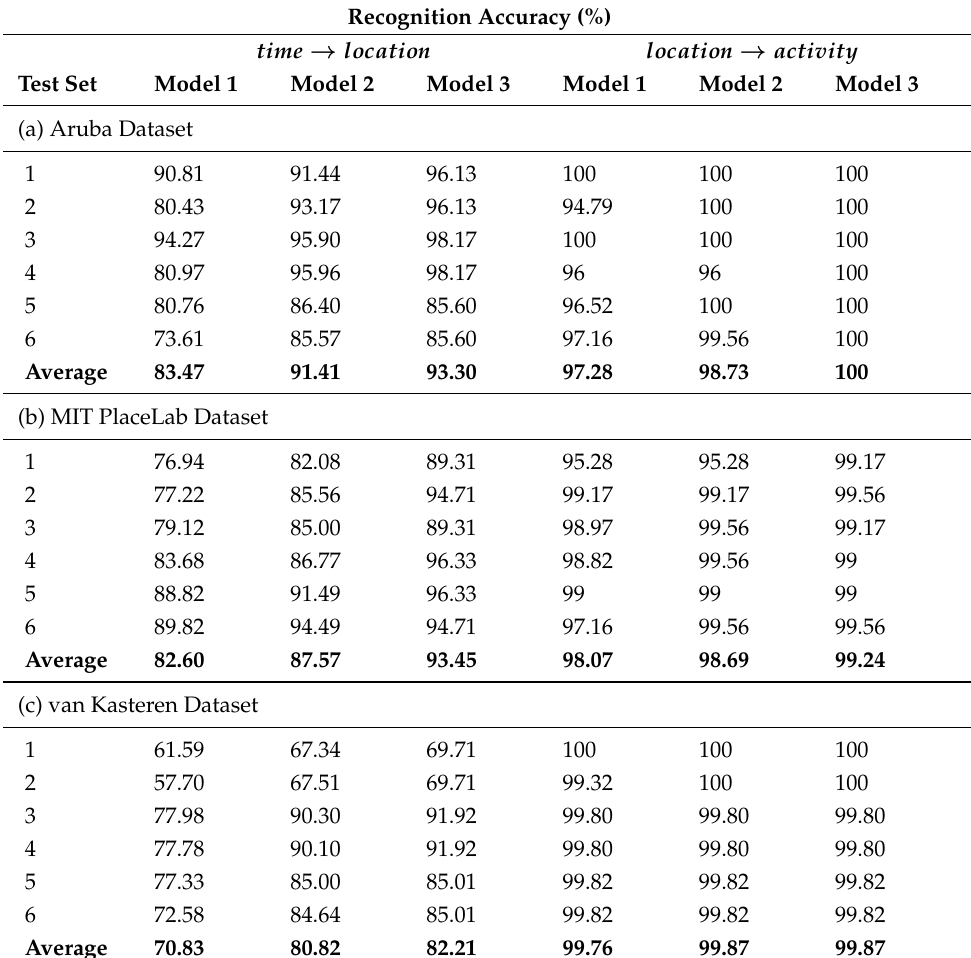
Table 4. Recognition performance for time → location and location → activity